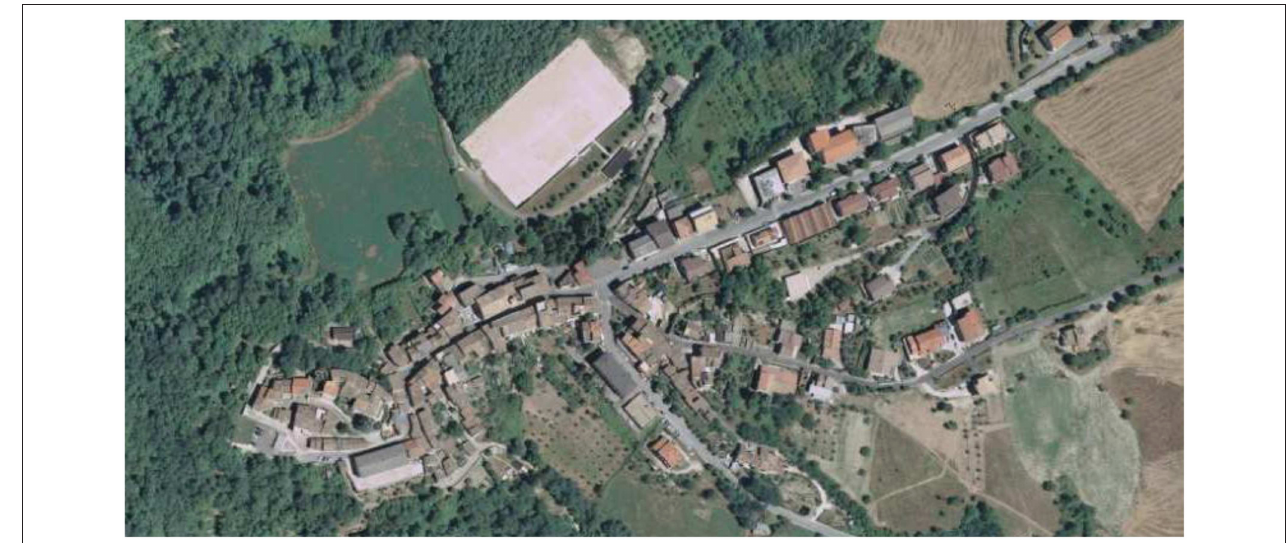
FIGURE 1 | Birds-eye view of the municipality of Arsita (source: Google